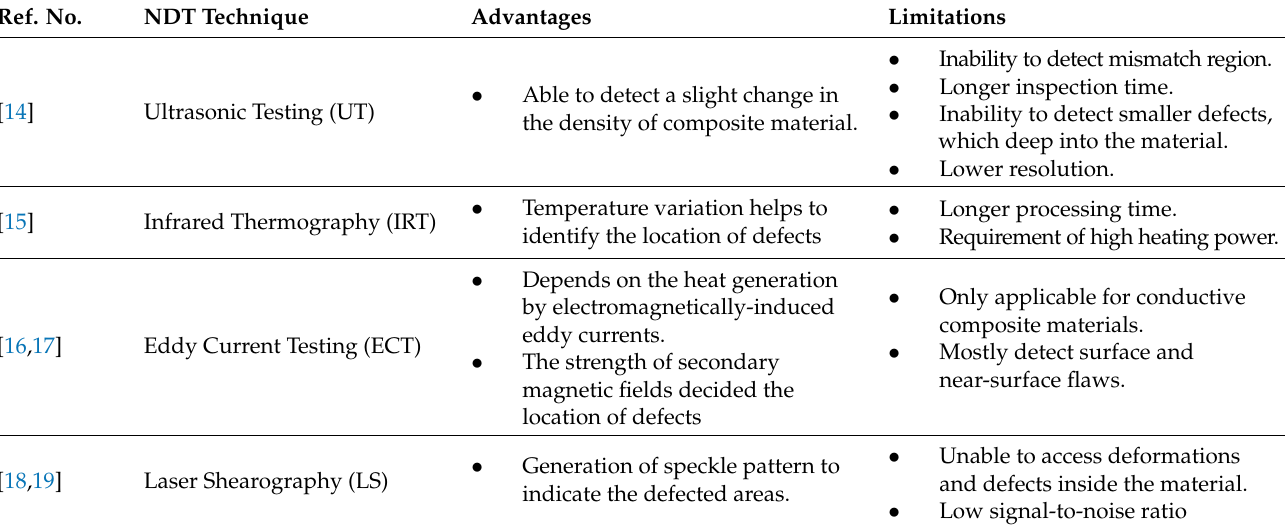
Table 1. Advantages and limitations for each traditional NDT technique.